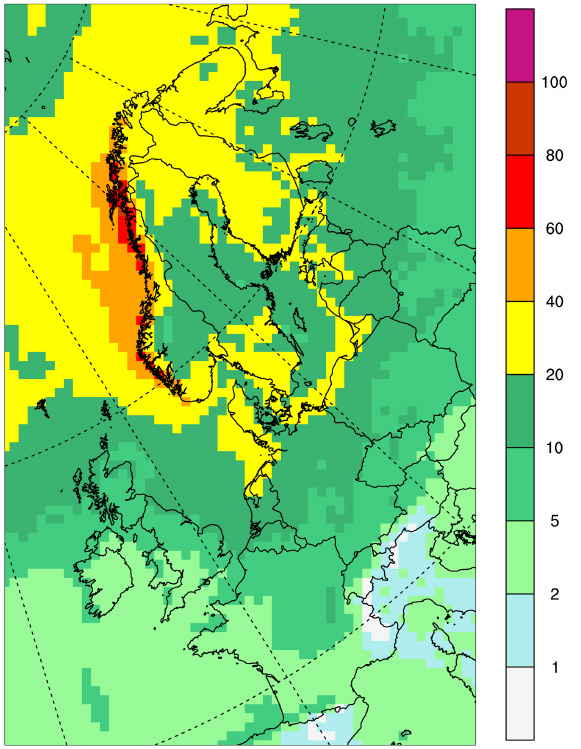
Figure 11. Increases in total N r deposition (mgm − 2 ) due to in- creased Arctic shipping emissions, including diversion routes in 2030. Results are relative to a 2030 base case. Calculations from EMEP MSC-W model, redrawn from Tuovinen et al. (2013).